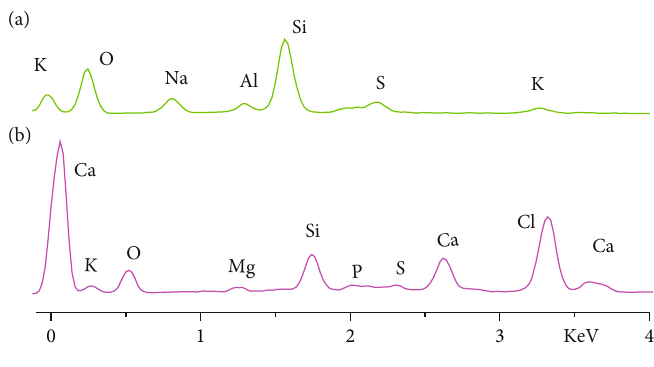
Figure 1: EDS analysis of (a) CSSC and (b) CS ash. Table 1: Elemental composition of CS ash and CSSC by EDS